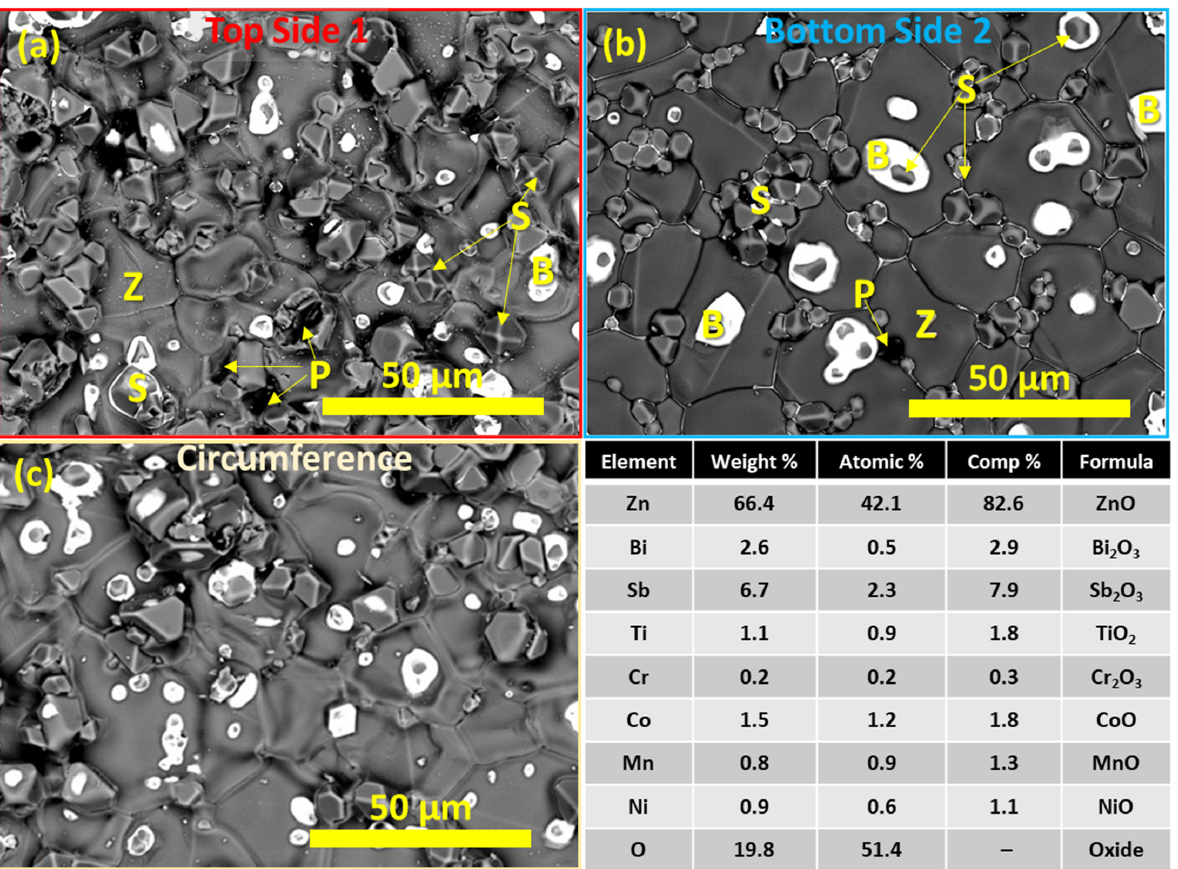
Figure 9. Backscattered (BSE) SEM characterization of the ZnO varistor prior to turning, with ( a ) showing the top side of the varistor in contact with air, ( b ) the bottom side 2 of the sample placed on a ceramic boat (microstructure in contact with smooth surface) and ( c ) representing the circumference region of the disk shaped varistor. The table at the end shows the weight, atomic and compound fractions of multiple phases of the EDXS quantified sample in the circumference region. The α -Bi 2 O 3 -rich intergranular phase (IP—defined by ‘B’ in Figure 9) at the grain boundaries (GBs), triple pockets and ZnO grain junctions appears as a bright constituent in the microstructure with a nominal thickness ranging from 0.1 to 1 µm depending on the sintering conditions [25,26]. Within the composition, Sb 2 O 3 is added to suppress ZnO